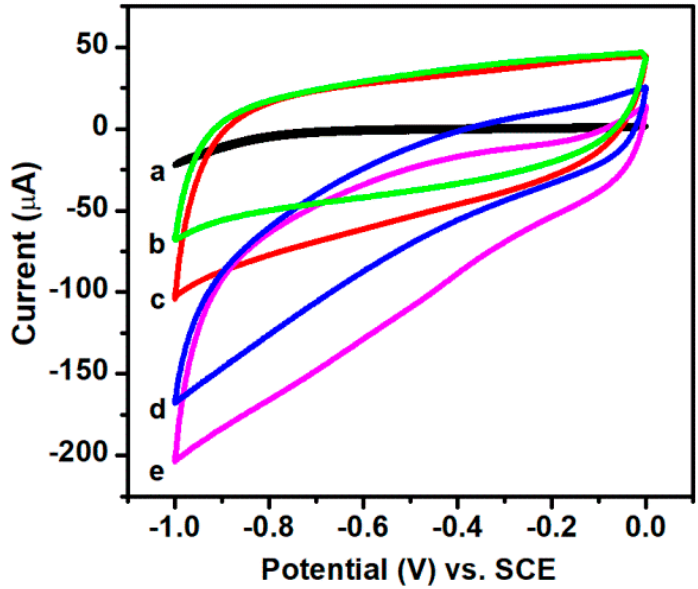
Figure 5. Cyclic voltammetry (CV) curves of bare GCE obtained in the presence of 3 mM H 2 O 2 ( a ); CV curves of AuNPs/RGO modified electrode obtained in the absence ( b ) and presence of 3 mM H 2 O 2 ( d ); and Ag-AuNPs/RGO modified electrode in the absence ( c ) and presence of 3 mM H 2 O 2 ( e ). Scan rate: 50 mV·s − 1 .